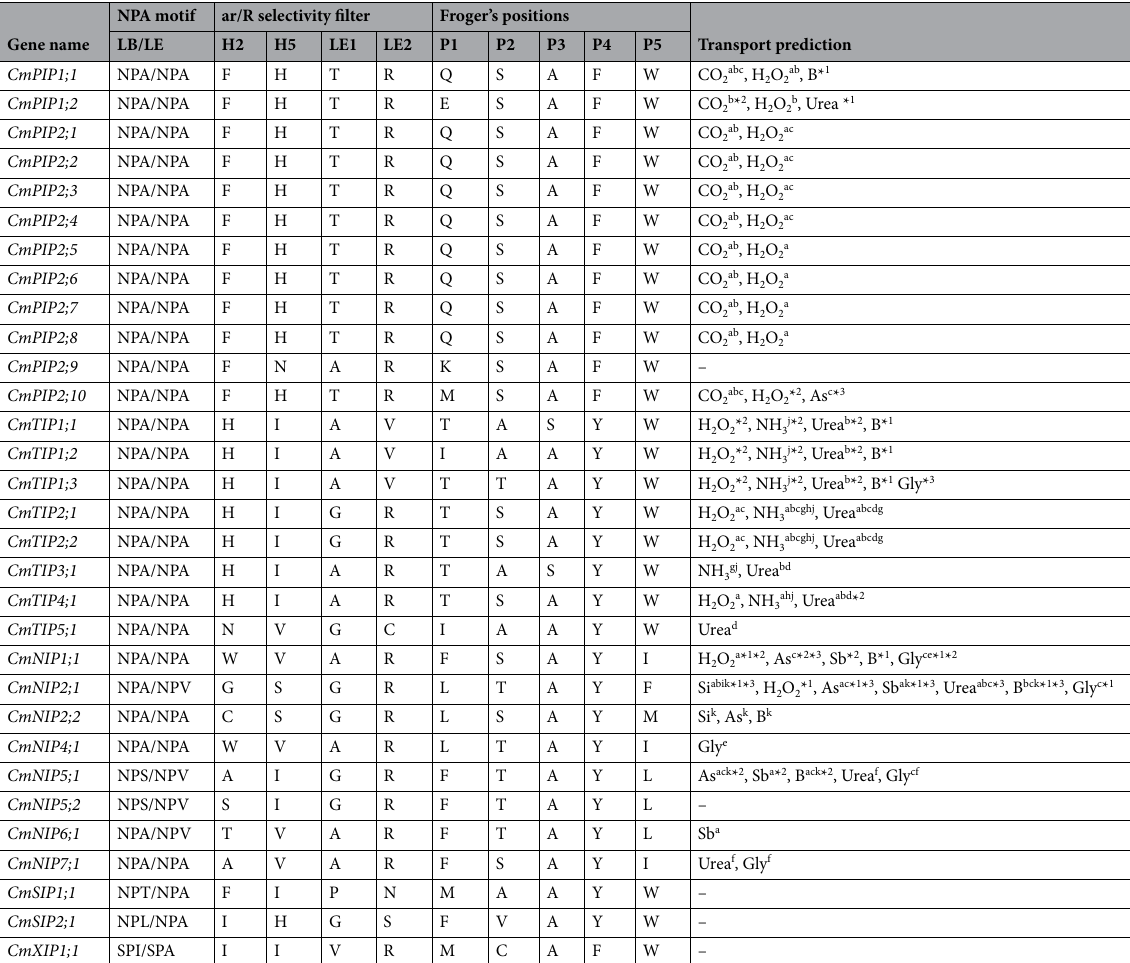
Table 3. Identification of important residues and transport prediction for C. melo (Cm) aquaporins. Columns: gene name; NPA motif (LB and LE positions); ar/R selectivity filter (H2, H5, LE1, LE2), Froger’s positions (P1–P5) and transport prediction. Shortening codes: LB, loop B; LE, loop E; H, hélix; Si, silicon; B, boron; As, arsenic; Sb, antimonite; Gly, glycerol. Aminoacide residues named with letters according the international code. a Transport prediction according to Azad et al. 12 . b Transport prediction according to Hove and Bhave 10 . c Transport prediction according to Perez Di Giorgio et al. 11 . d Transport prediction according to Dynowski et al. 28 . e Transport prediction according to Wallace et al. 29 . f Transport prediction according to Wallace and Roberts 27 . g Transport prediction according to Azad et al. (2011). h Transport prediction according to Kirscht et al. 74 . i Transport prediction according to Deshmukh et al. 85 . j Transport prediction according to Jahn et al. 30 . k Transport prediction according to Mitani-Ueno et al. 26 . * 1 prediction based on Zea mays L.